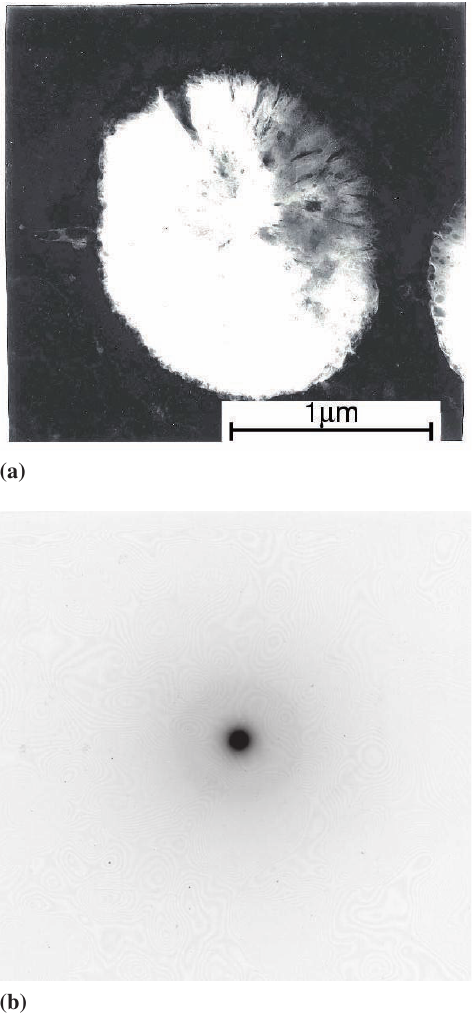
Figure 9. TEM observation results of a 1 µm particle obtained in experiment II (Humid, 95°C, A) at 24 h. (a) Bright field image, (b) electron beam diffraction pat-